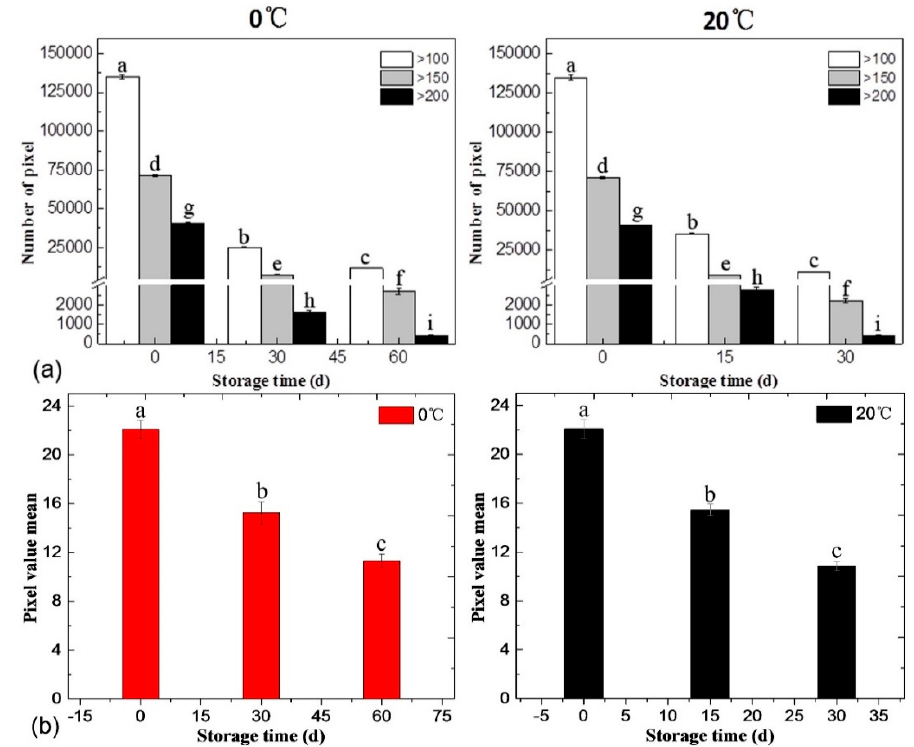
Figure 5. Statistics of pixel value distribution ( a ) and pixel value mean ( b ) in the SRS hyperspectral image of peach stored at 0 °C and 20 °C. The bars represent standard deviation. The same superscript letters above the bars mean no signi fi cant difference at p = 0.05. The effect is signi fi cant with p < 0.05.